Question: Give a one-sentence summary of this figure.
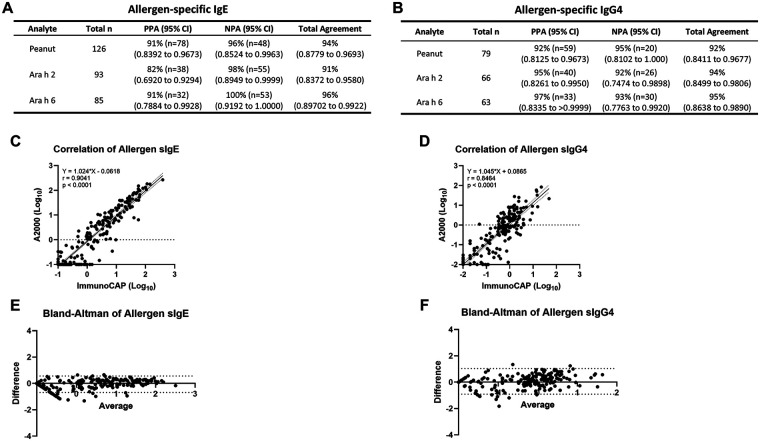
Answer: Analytical comparison between A2000 Plus and ImmunoCAP. (A,D) The Autolumo A2000 Plus demonstrated high qualitative agreement with ImmunoCAP for sIgE and sIgG4 measurements of peanut, Ara h 2, and Ara h 6, as assessed by sensitivity, specificity, and total class agreement compared to ImmunoCAP. (B,E) sIgE and sIgG4 measurement for peanut, Ara h 2, and Ara h 6 together showed strong correlation between the Autolumo A2000 Plus and ImmunoCAP platforms through Spearman's rank correlation. The correlation coefficients (ρ) for sIgE and sIgG4 were 0.9041 and 0.8464, respectively. (C,F) Bland-Altman diagrams plot differences (ordinate values, in log 10 ) in sIgE and sIgG4 measurements between A2000 and ImmunoCAP against average values (abscissa, log 10 ). R, Spearman's ρ .